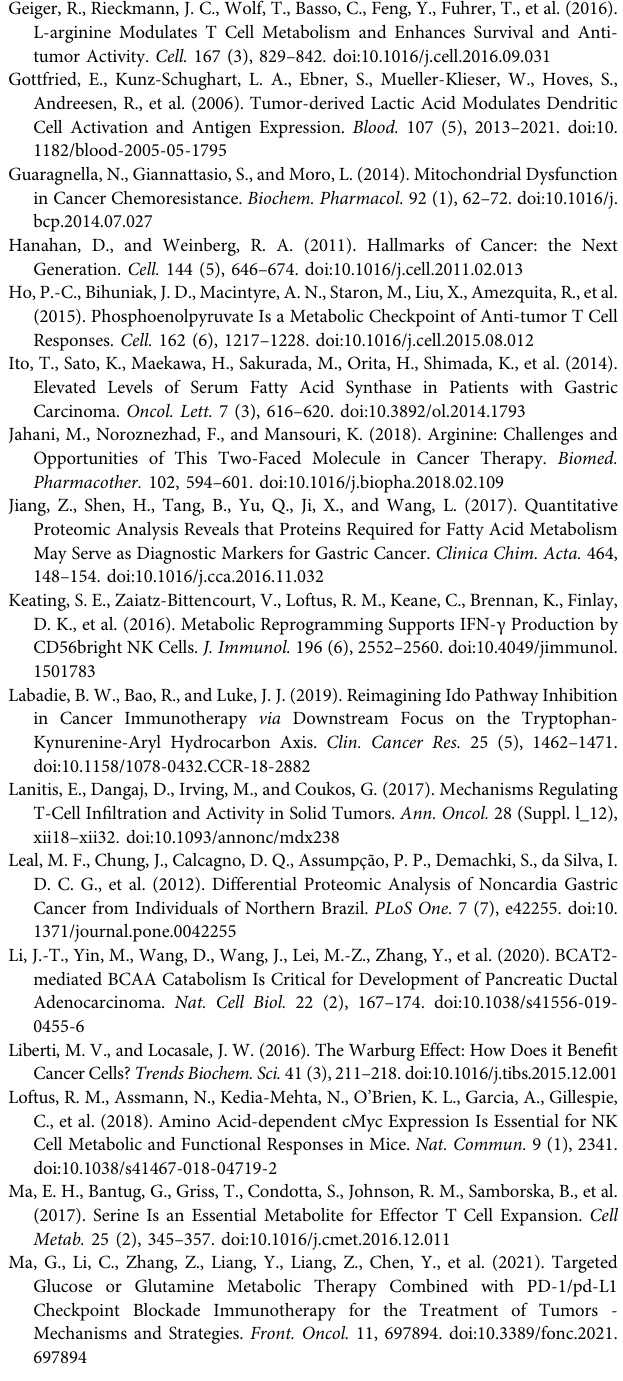
differentially expressed protein identi fi ed by the proteome. Fifty-seven differentially expressed proteins (mRNAs) were identi fi ed both in the proteomics and transcriptomics. (C) The KEGG pathway bias plot shows the detailed pathway of dysregulated proteins (mRNAs) both in proteomics and transcriptomics. The biased-ratio represents the ratio of dysregulated proteins (mRNAs) with positive/ negative correlation in the total dysregulated proteins (mRNAs). (D) The scatter plot shows the metabolic activity pathway exhibited a positive correlation in proteomics and transcriptomics. (E) Heat map of 14 metabolic gene expression in proteomics and